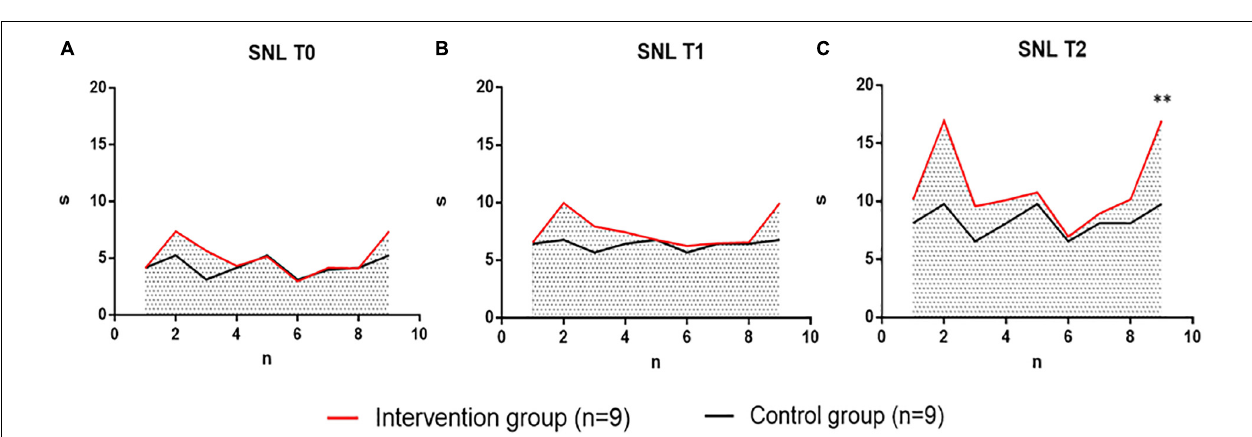
FIGURE 7 | The intervention group performing vocal therapy (VIT) compared with the control group for respiratory pronunciation training at three-time points of time (Sustained Note Length, SNL, s) at T0, T1, T2. Intervention group, intervention group, indicated in red. Control group, control group, black indicates. (A) Individual difference distribution of SNL values at T0 time points between patients in the intervention group ( n = 9) and patients in the control group ( n = 9). (B) Individual difference distribution of SNL values at T1 time points between patients in the intervention group ( n = 9) and patients in the control group ( n = 9). (C) Individual difference distribution of SNL values at T2 time points between patients in the intervention group ( n = 9) and patients in the control group ( n = 9). s, Seconds; n, the number of participants; T0, baseline; T1, after 6 weeks; T2, after 12 weeks. ∗∗ p < 0.01, with significant differences between